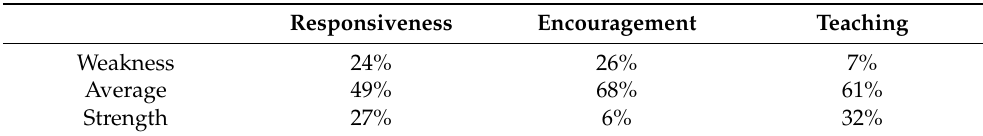
Table 1. Distribution of the mothers’ parental interaction quality.